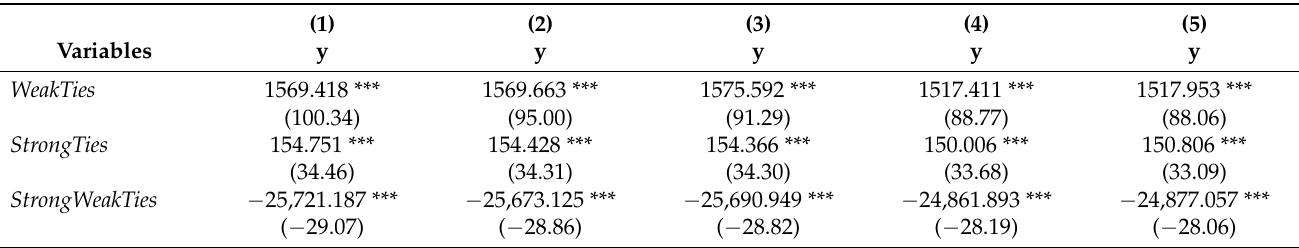
Table 5. Robustness